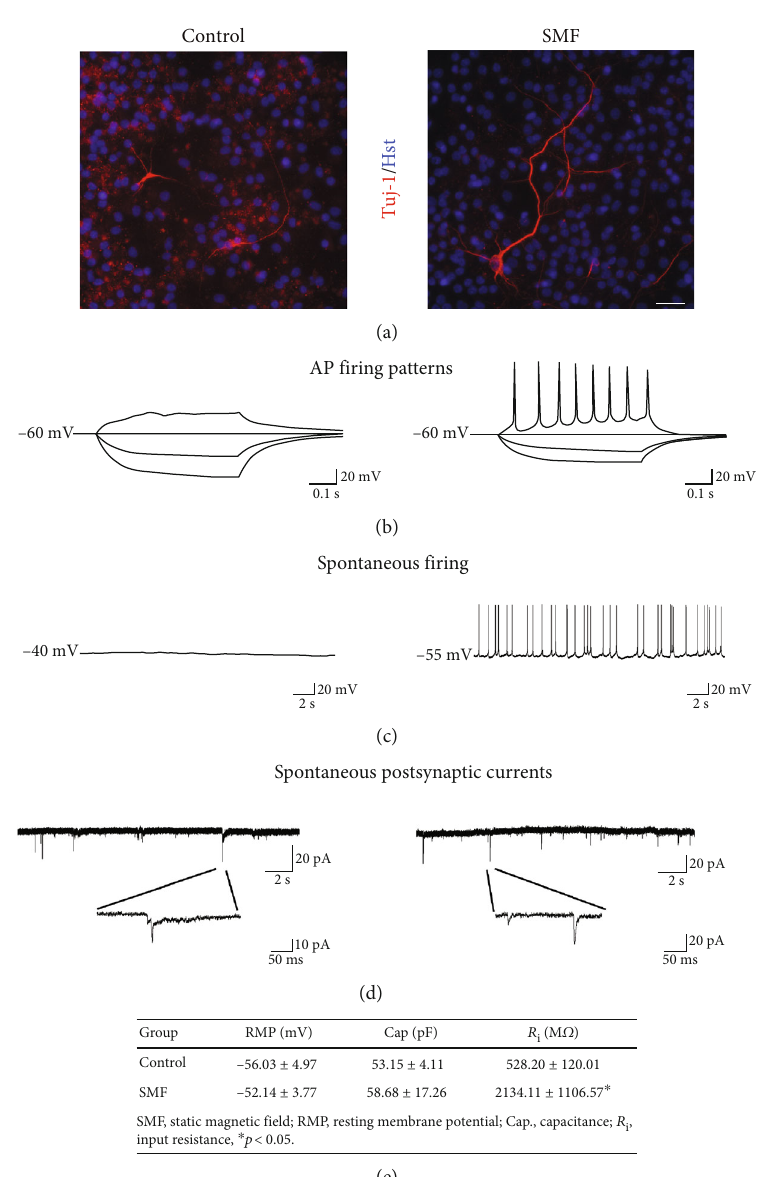
Figure 5: Electrophysiological characterization of the mNPC-derived neuron. (a) Representative images showing the Tuj1 staining for the neurite outgrowth of mNPC-derived neurons. SMF stimulation (right panel) markedly increased the length and the branching of neurites than control neuron (left panel). Scale bar, 25 μ m. (b) Responses of the mNPC-derived neuron to current injections (-60, -30, 0, +30pA, duration, 500 ms, holding potential, -60 mV). (c) Representative current-clamp recordings of the mNPC-derived neuron. After exposure to SMF, mNPC-derived neuron exhibited spontaneous repetitive AP fi ring. (d) Representative examples of spontaneous postsynaptic currents at 3 weeks after di ff erentiation (recordings were taken without blockers of synaptic transmission). Both control and SMF groups are showing spontaneous postsynaptic currents. (e) mNPC-derived neuron displayed a signi fi cantly increased in R i but not RMP or Cap after exposure to SMF. ∗ p < 0 : 05 ; Student ’ s t